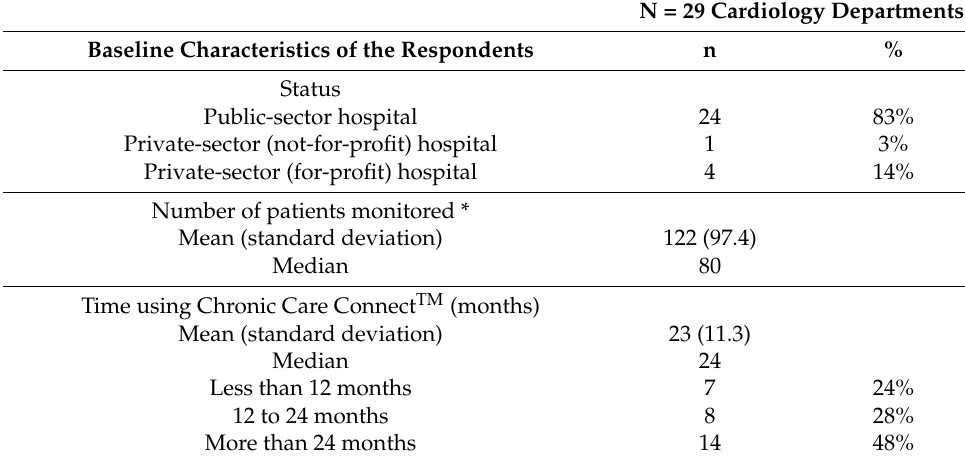
Table 2. Baseline characteristics of the